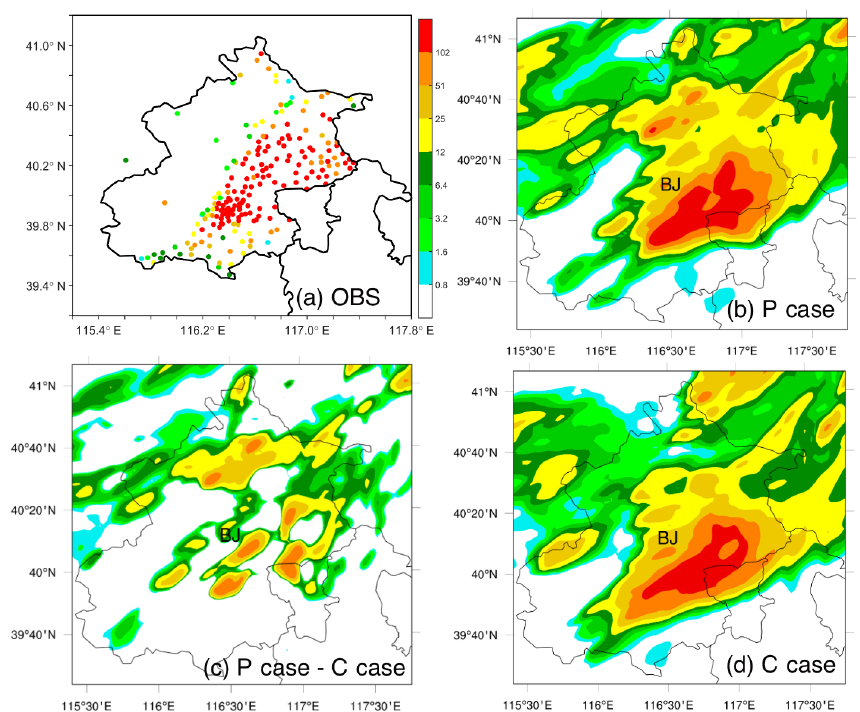
Figure 7. Comparison of accumulated precipitation (units: mm) between observation (11:00–17:00UTC) and simulations (10:00– 16:00UTC). (a) Observation. (b) P case and (d) C case. And (c) difference in accumulated precipitation (units: mm) between the P and C cases. BJ is Beijing.